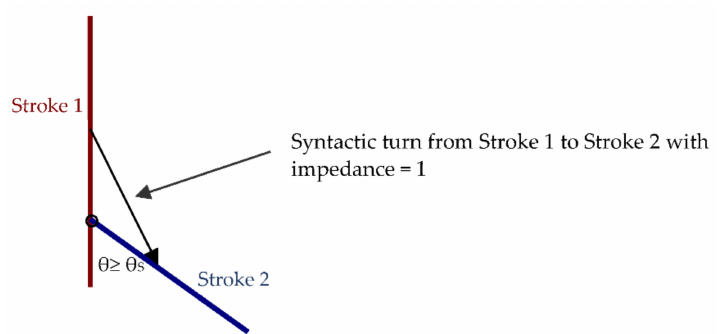
Figure 4. Syntactic turn